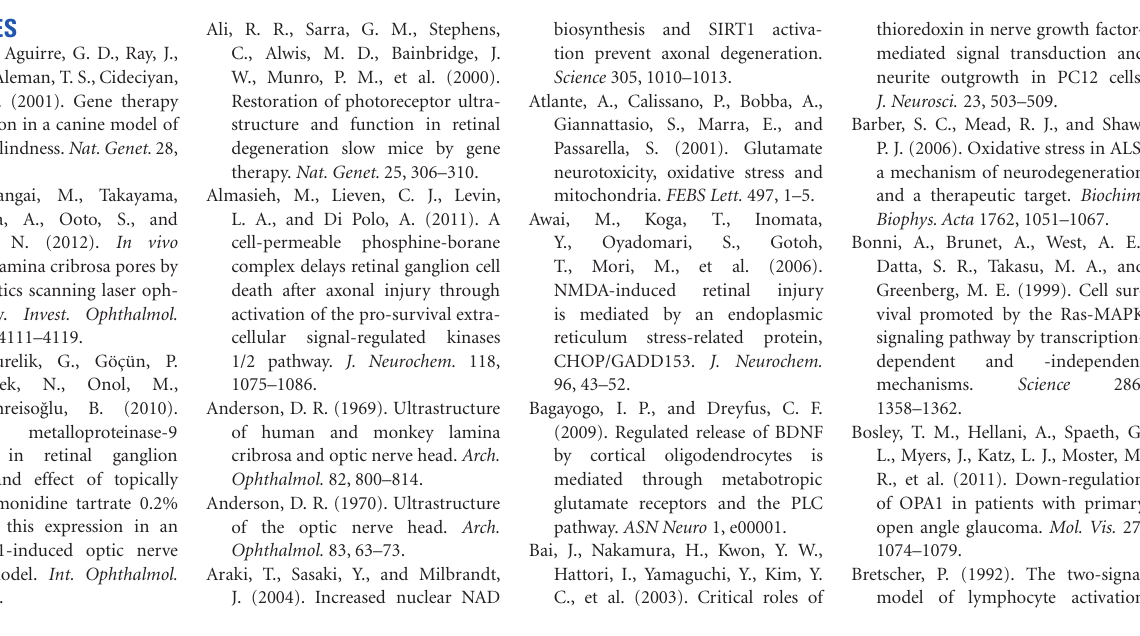
signal activation in RGC body, including release of ROS from mitochondria, autoimmune dysregulation, and avtivation of glutamate transporter. TNF, Tumor Necrosis Factor; Trx1, thioredoxin1; NAD,nicotinamide adenine dinucleotide; BDNF, Brain-derived neurotrophic factor; NMDAR, N-methyl-D-aspartate receptor; ER, endoplasmic